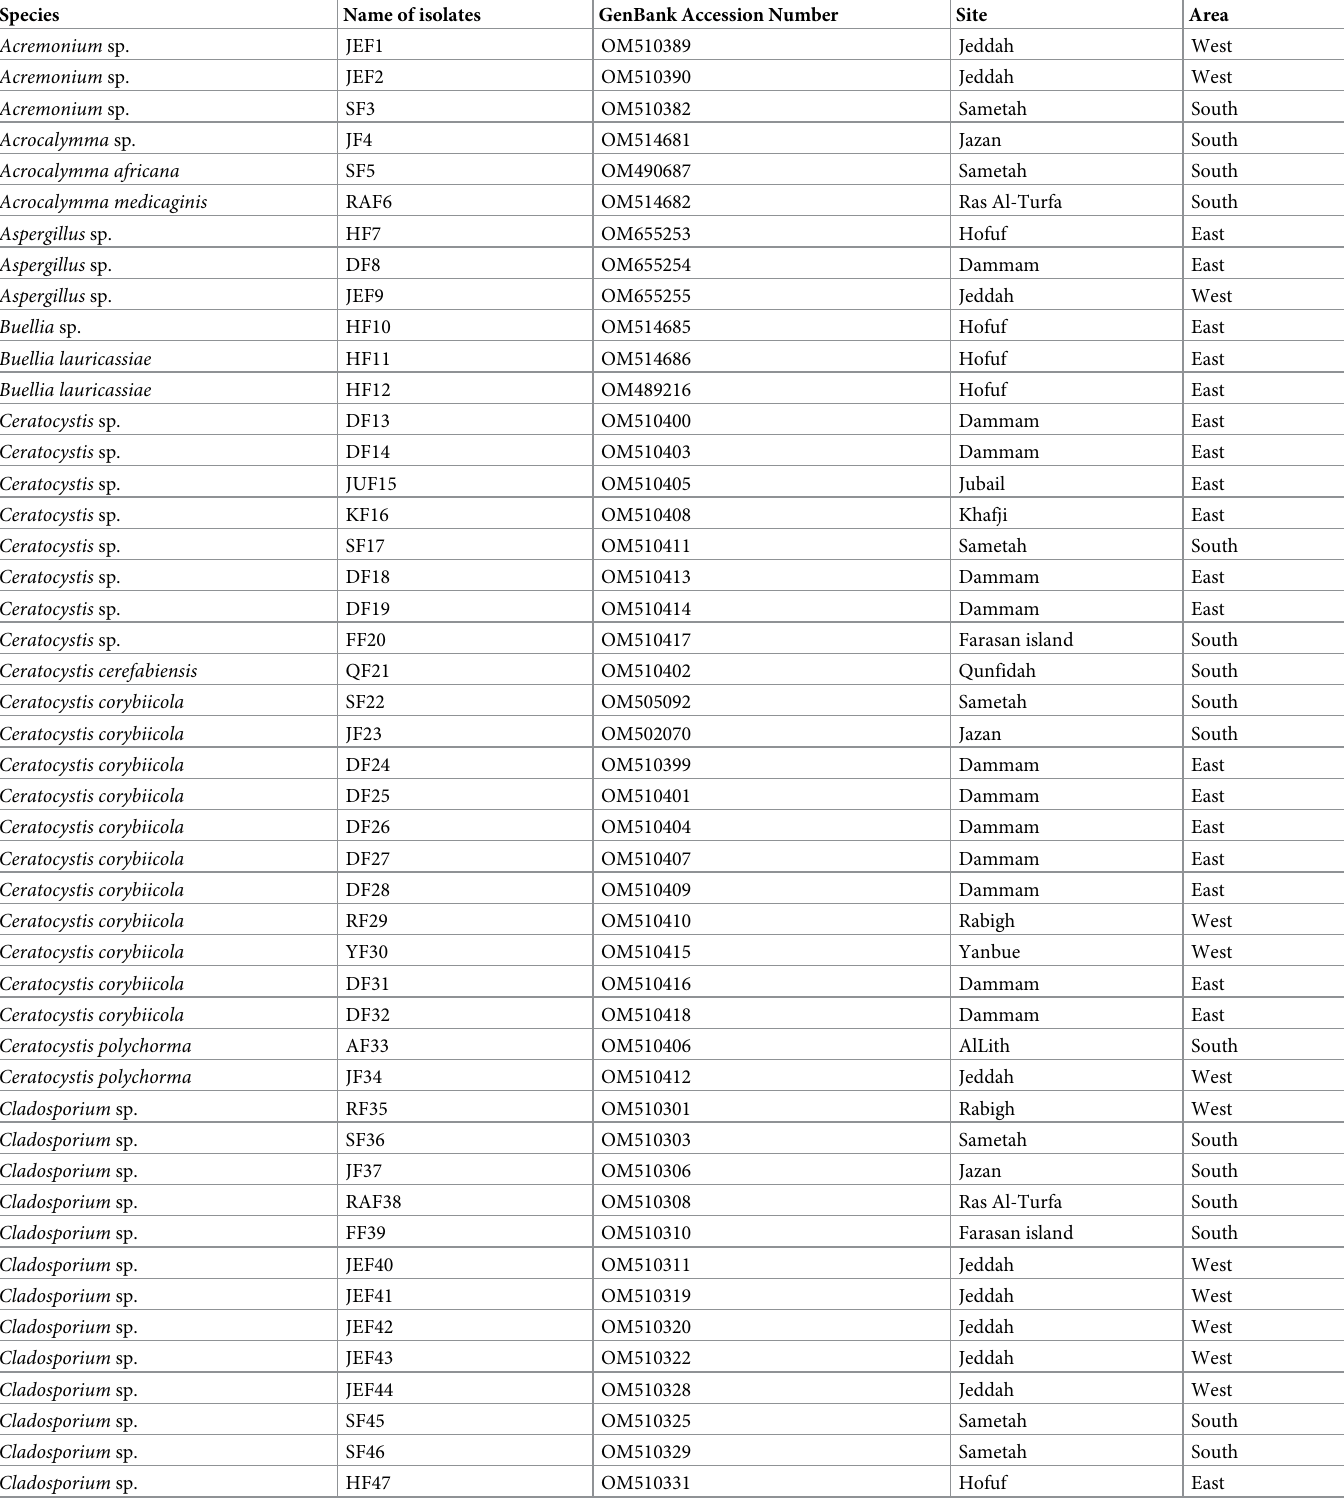
Table 1. Marine fungi with their National Center for Biotechnology Information (NCBI) accession numbers isolated from different areas in Saudi Arabia.